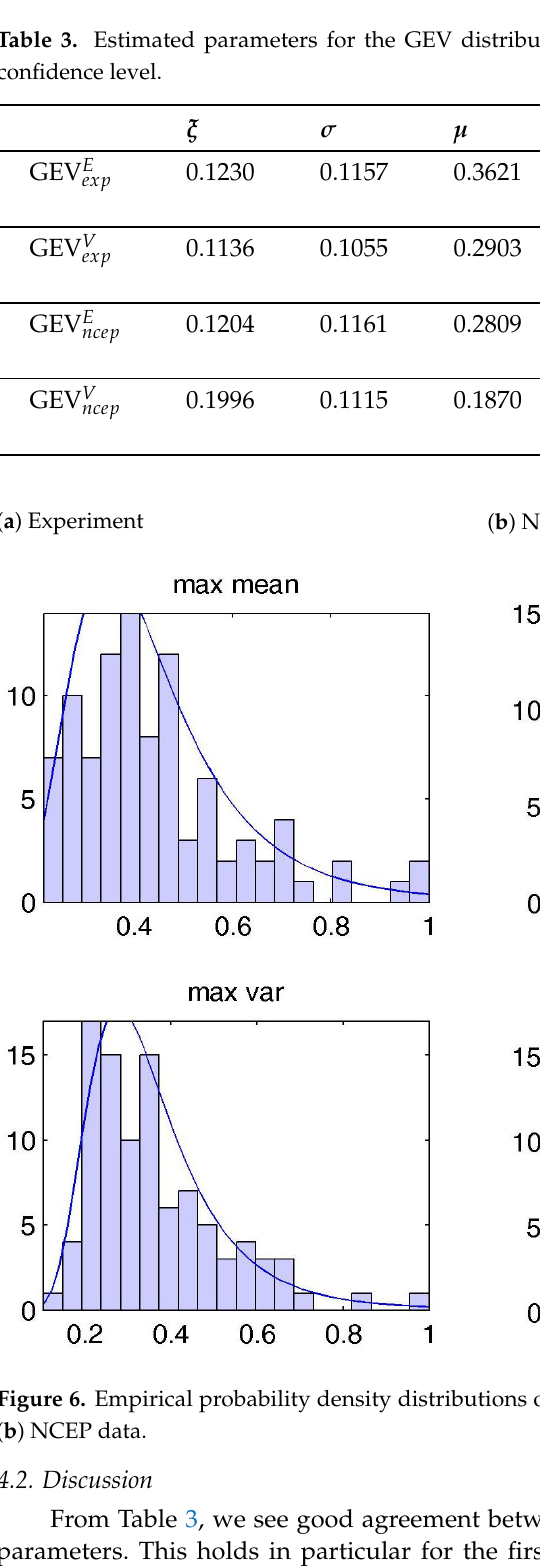
Figure 6. Empirical probability density distributions of E (cid:48) ( b ) NCEP